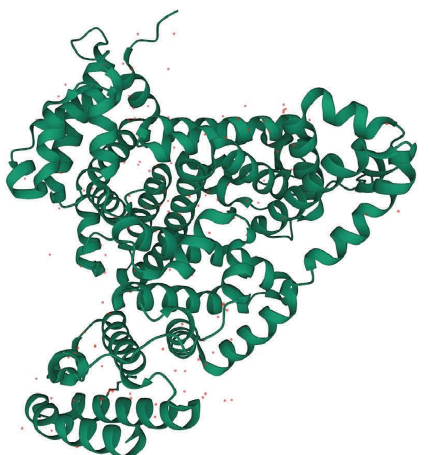
Figure 1: Tree-dimensional structure of simple BSA protein (downloaded from protein data bank; ID: 4F5S (https://www.rcsb.